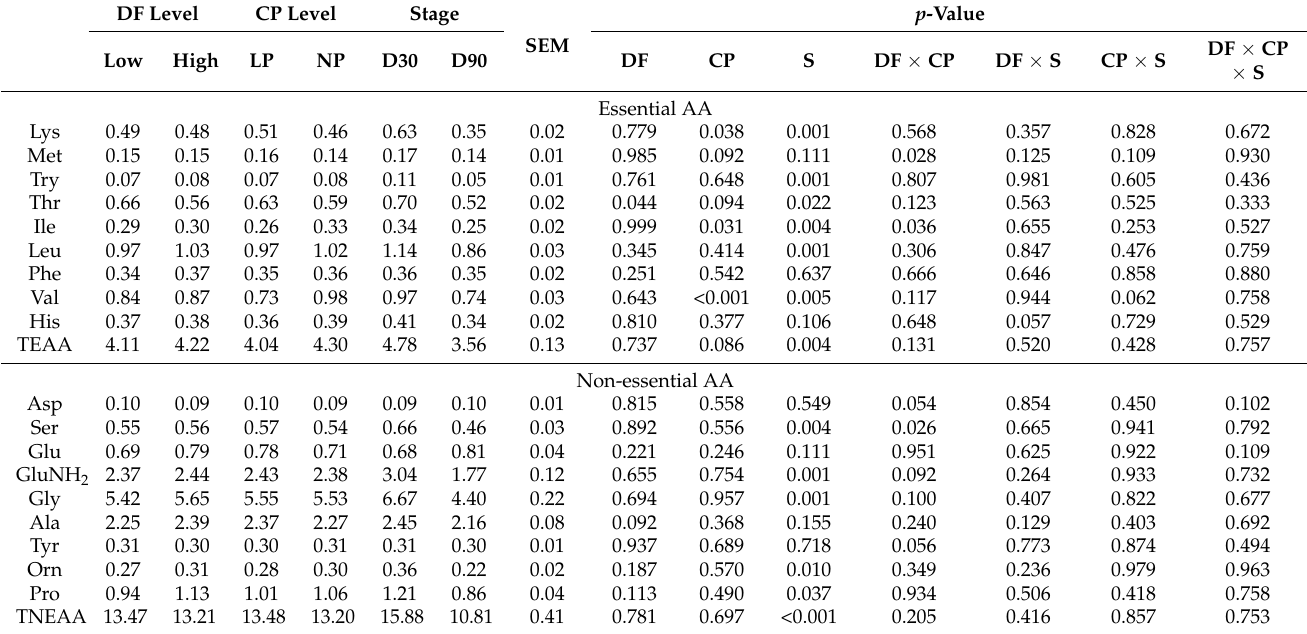
Table 4. Effects of dietary fiber and crude protein levels on serum levels of amino acids (mmol/L) in gestating sows at different gestational